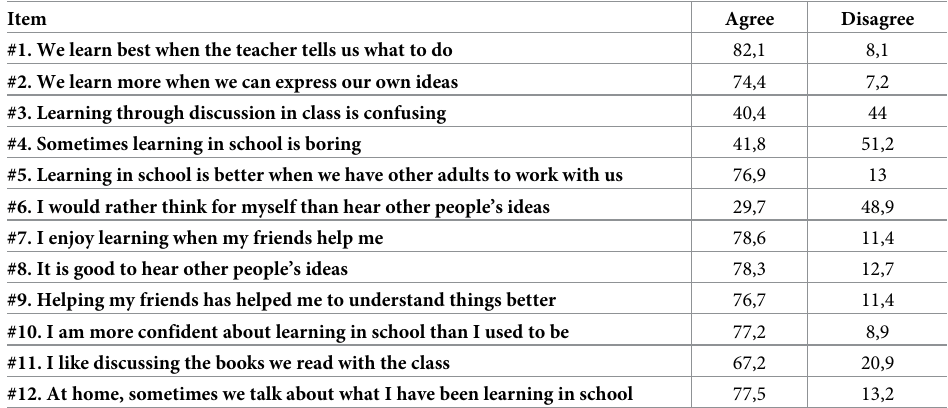
Table 4. Valid percent of students’ answers participating in IGs and DLGs